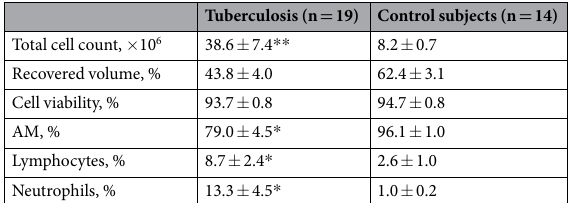
Table 1. Characteristics of bronchoalveolar lavage in control subjects and patients with active pulmonary tuberculosis. AM = alveolar macrophages. Values presented as means ± SEM. * p < 0.05, ** p < 0.001 compared with control subjects.